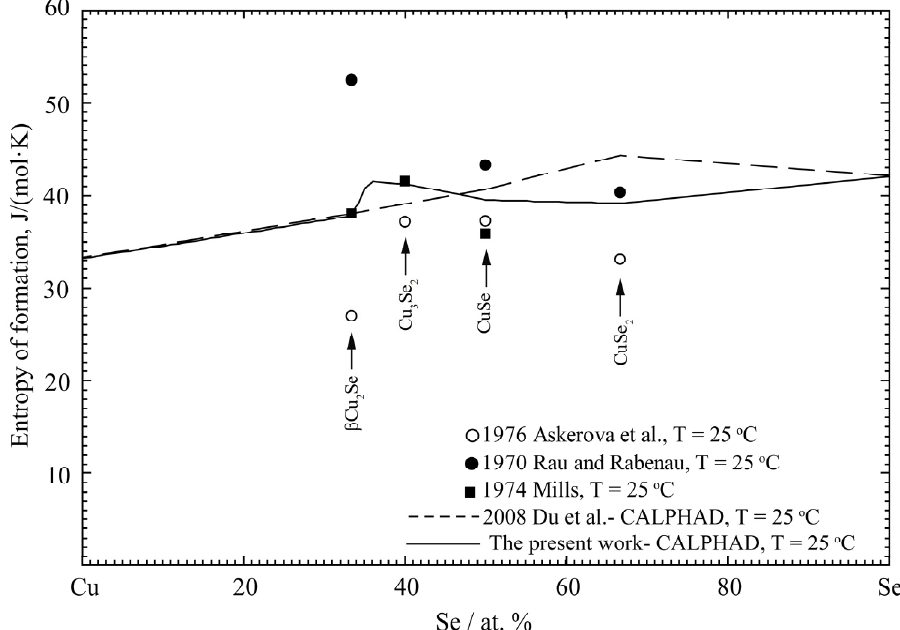
Figure 9. The calculated standard entropy of formation at 25 °C in the Cu-Se system compared with the experimental data from refs. [93–95] and previously optimized results by Du et al. [100].